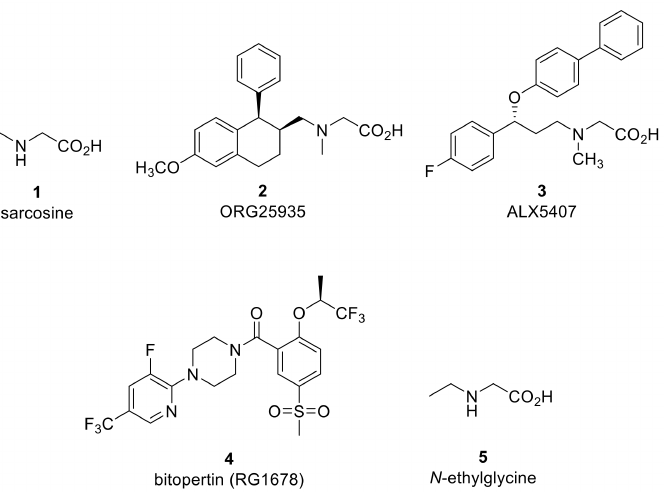
Figure 2. GlyT1 inhibitors studied in preclinical in vivo rodent pain